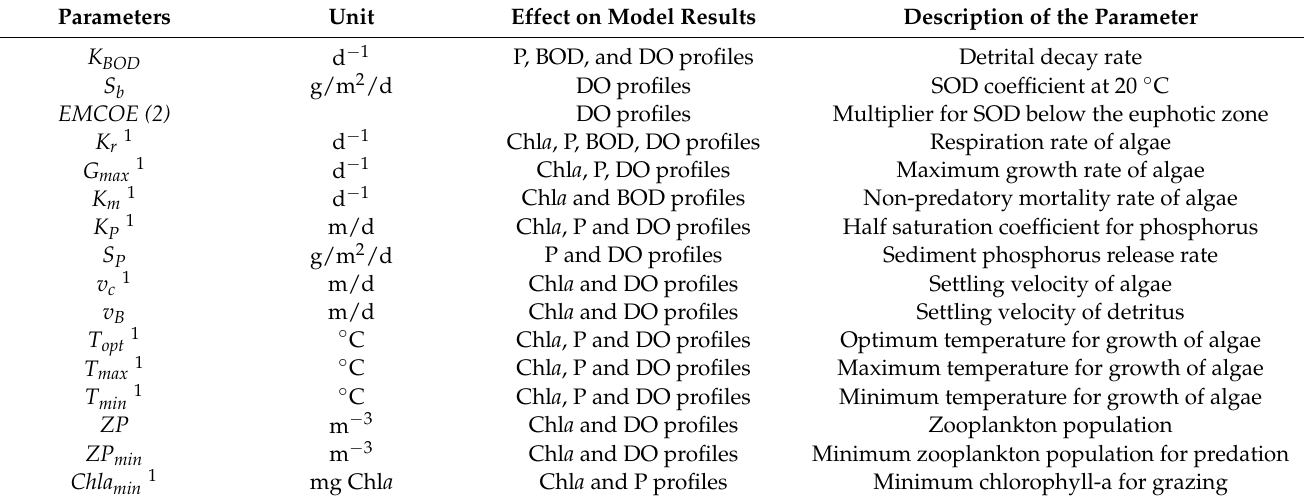
Table 1. Nutrient, Chl a , and DO calibration parameters for